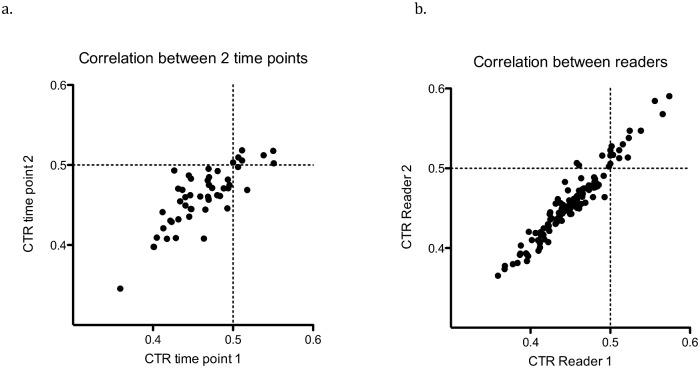
Correlation between timepoints and readers.a. Scatter plot showing correlation of cardiothoracic Ratio (CTR) for 51 participants with repeat chest radiograph (CXR) 4–12 weeks apart read by a single reader. Top left and bottom right quadrants represent differences in classification of cardiomegaly between reads. b. Scatter plot showing correlation of CTR for 113 participants determined independently by 2 readers. Top left and bottom right quadrants represent differences in classification of cardiomegaly between readers.